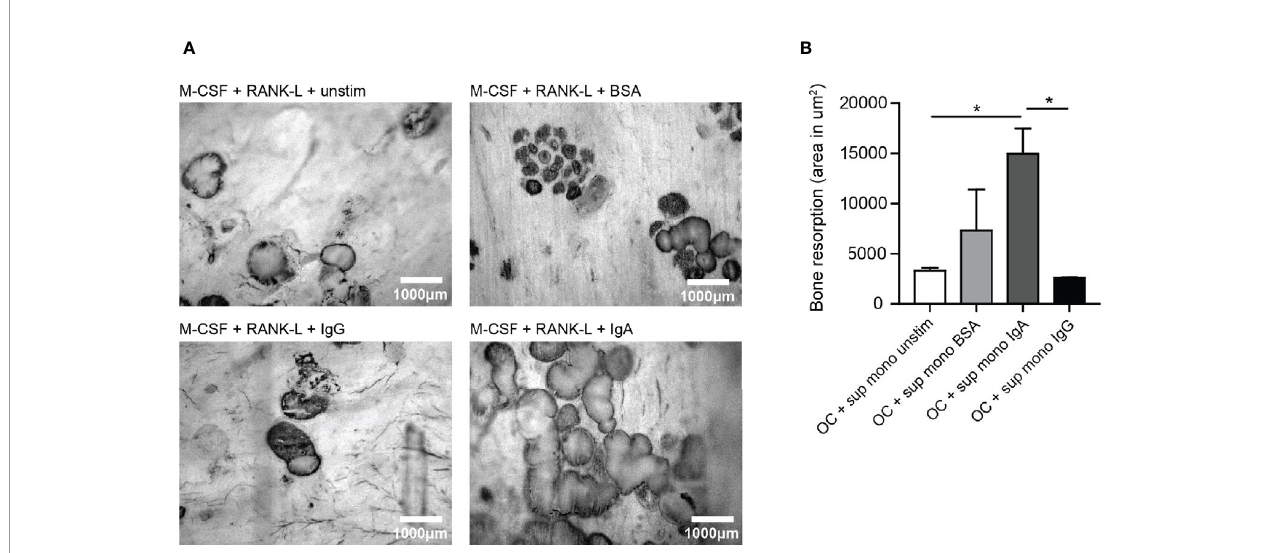
FIGURE 4 | Signi fi cantly enhanced bone resorption in presence of supernatant of IgA-activated monocytes. (A) Bone resorption by osteoclasts in the presence of supernatant of unstimulated monocytes (upper left panel), BSA-stimulated monocytes (upper right panel), IgG-activated monocytes (lower left panel), or IgA-activated monocytes (lower right panel). (B) Quanti fi cation of bone resorption (area in um 2 ) induced by osteoclasts in presence of supernatant of unstimulated monocytes (white bar), BSA-activated monocytes (light grey bar), IgA-activated monocytes (dark grey bar) or IgG-activated monocytes (black bar). Data was analyzed using one way ANOVA with Tukey post-hoc; * p ≤